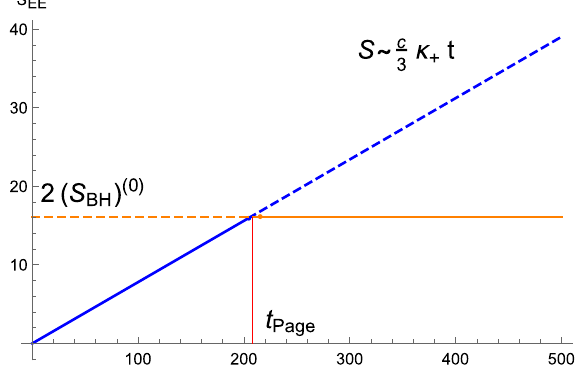
Fig. 4 Page curve of an eternal Reissner–Nordström black hole by considering only leading order term in G N